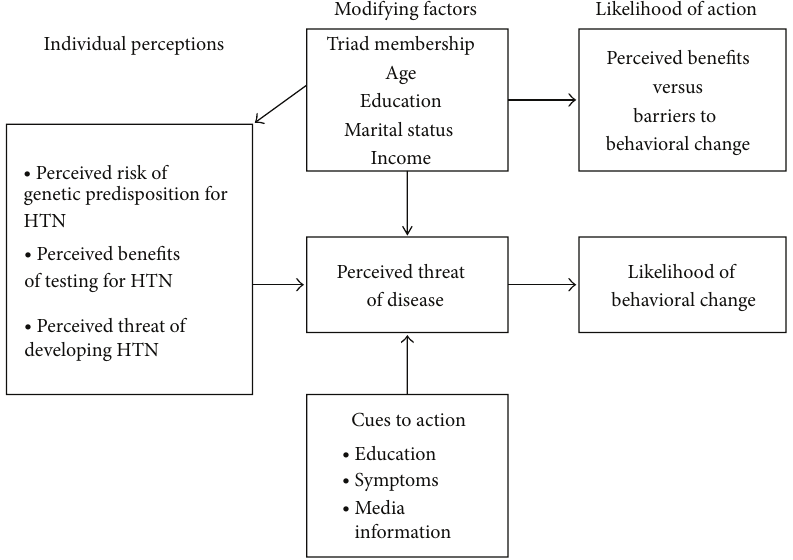
Figure 1: Health belief